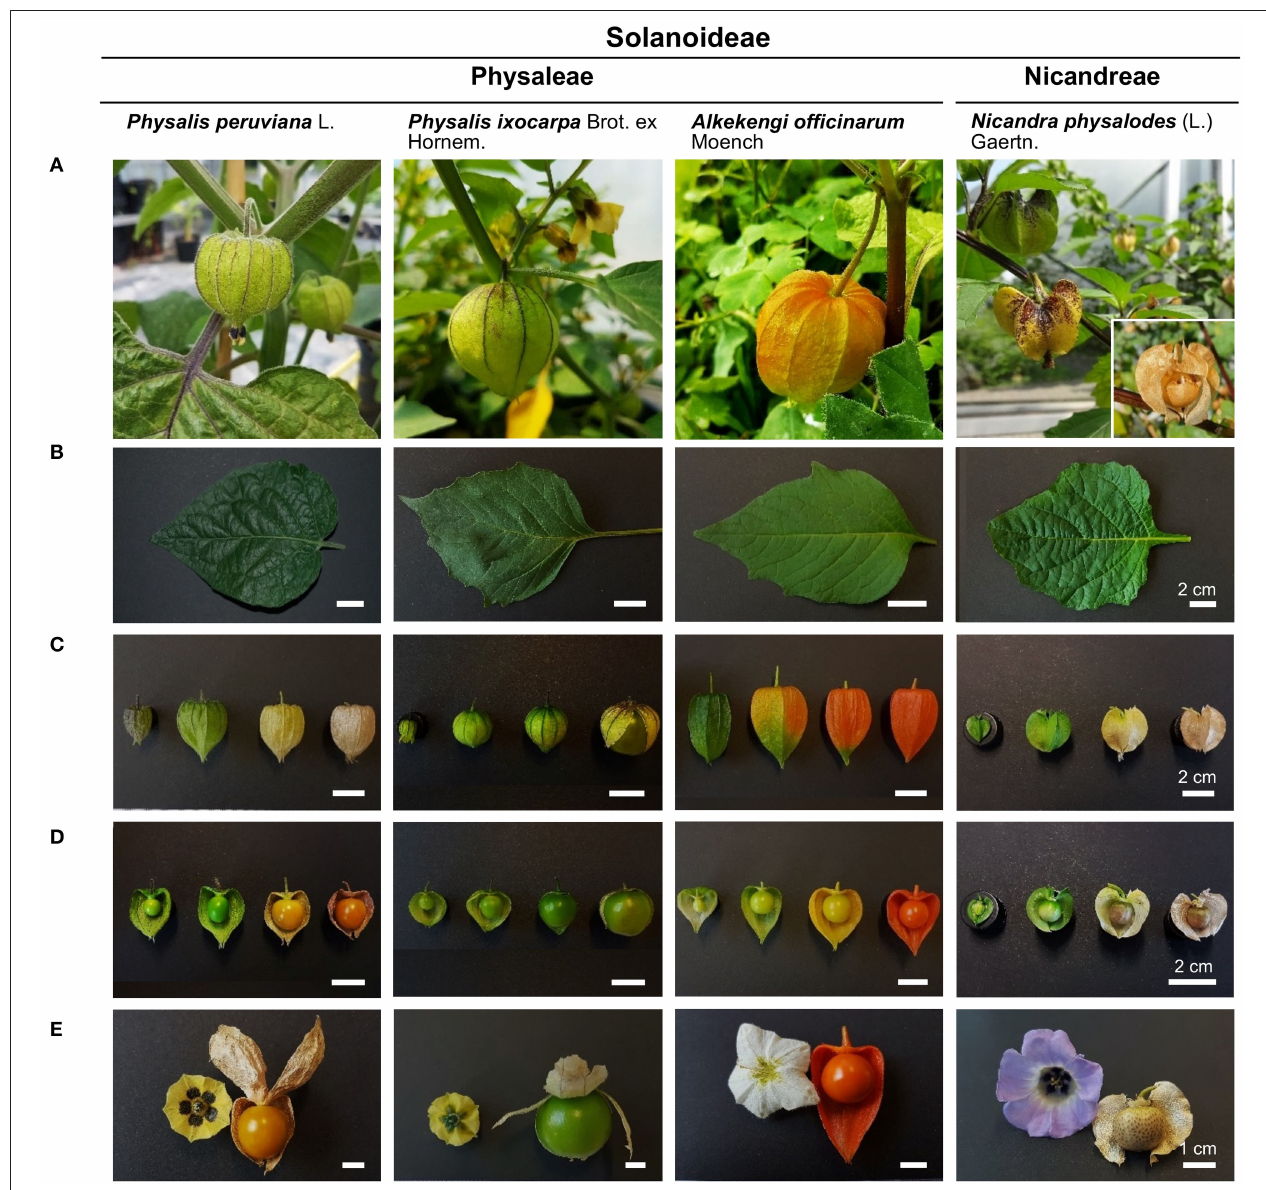
FIGURE 1 | Morphological characteristics of leaves, fruiting calyces, and fruits of Physalis , Alkekengi, and Nicandra species belonging to the Physaleae and the Nicandreae tribe of the Solanoideae subfamily (A) . Fully expanded leaves are simple, ovate or ovate-elliptic (B) . Persistent sepals of the inflated fruiting calyces (C) change in extent, architecture, and color during fruit maturation (D) . Yellow, white, or blue petals form a tube with terminal lobes or teeth. Ripe fruits represent globose berries that bear a five-lobed fruiting calyx (E)